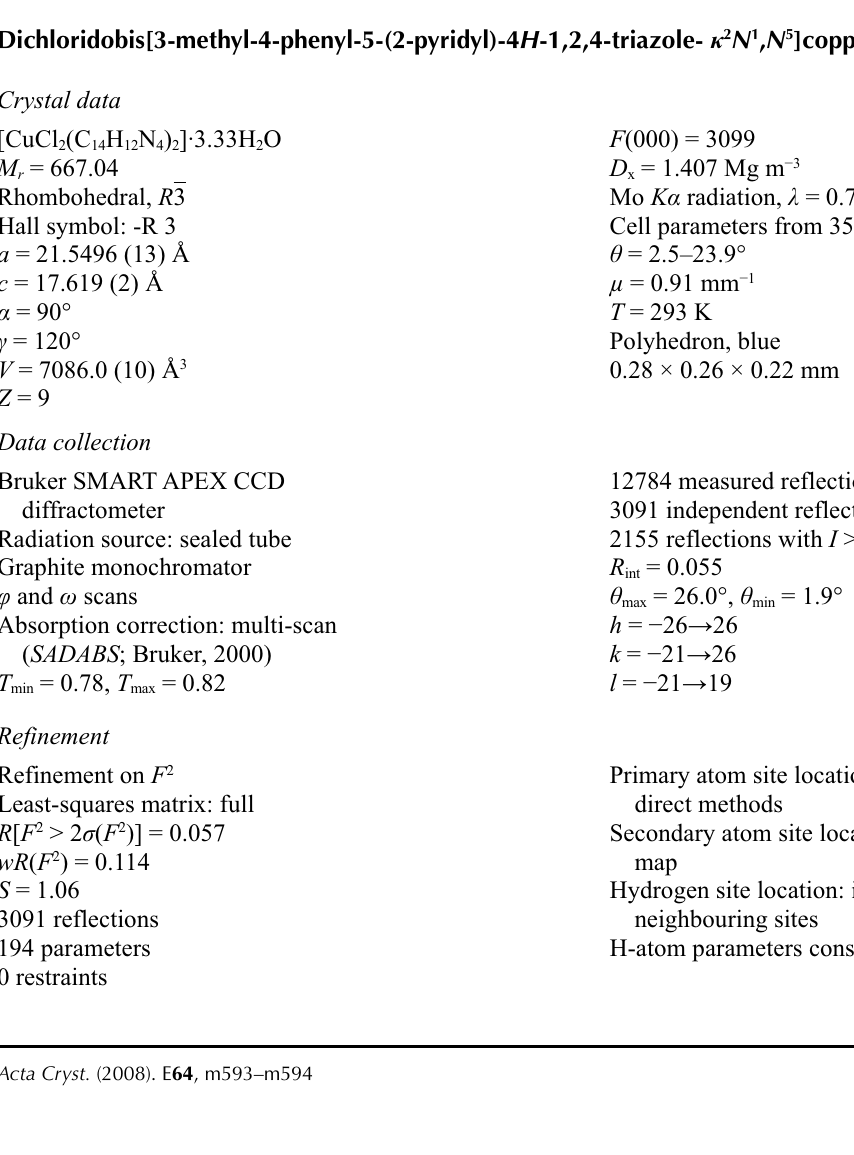
Figure 1 The molecular structure of the title compound with the atomic labelling. Displacement ellipsoids are shown at the 30% probability level. [Symmetry code i: - x + 1, - y + 2, - z +